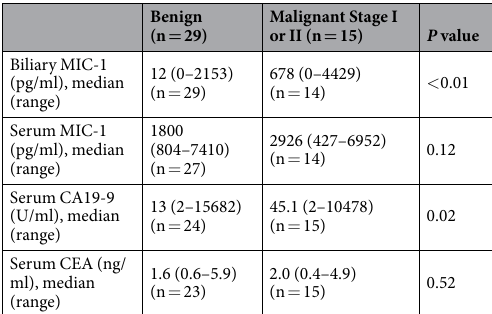
Malignant Stage I or II (n = 15) P value